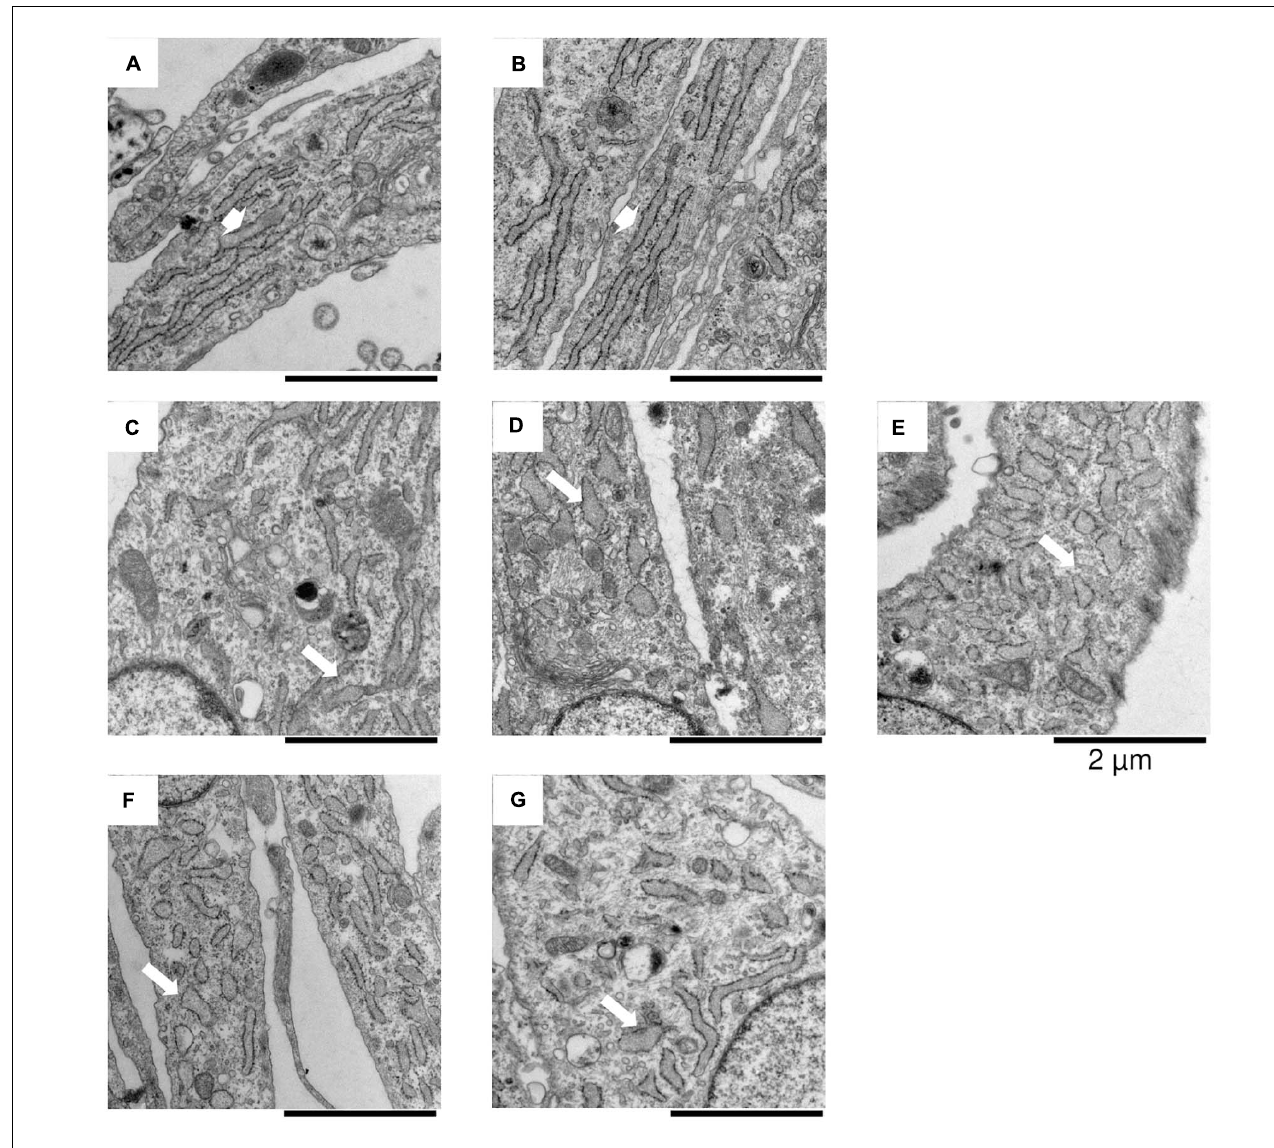
FIGURE 4 | In vitro electron microscopy analyses of fibroblasts derived from (A,B) healthy controls, (C–E) MBTPS2 -OI and (F,G) MBTPS2- IFAP/KFSD patients. In each image a portion of the fibroblasts is depicted with abundant ER cisterns. Short and large shaped ER cisterns are shown in the MBTPS2 -OI [ (C–E) , white arrows] and MBTPS2- IFAP/KFSD patients [ (F,G) , white arrows] in contrast to the long and slender shaped ER cisterns shown in the two controls [ (A,B) , white large arrows].